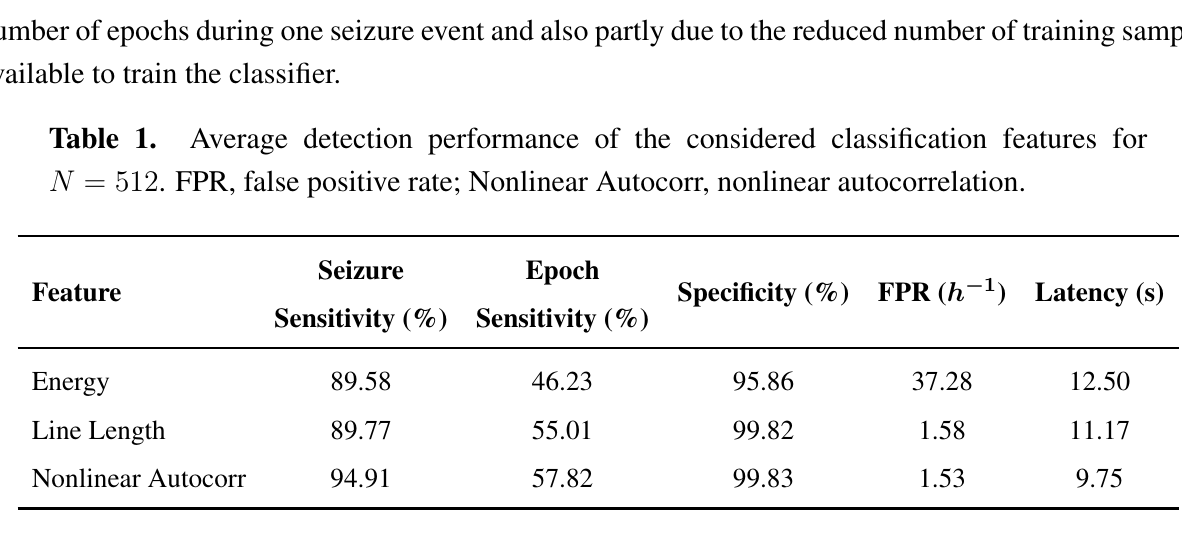
Figure 2. Detection performance as a function of the epoch size ( N